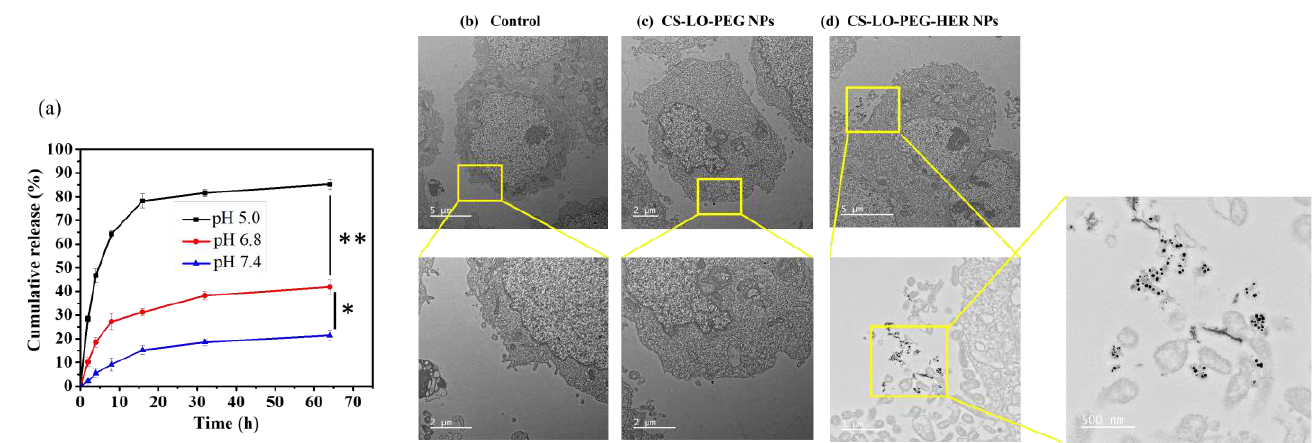
Figure 3. In vitro pH responsive enzyme release from the herceptin (trastuzumab) functionalized L-lysine α -oxidase loaded chitosan-polyethylene glycol (PEG) nanoparticles (CS-LO-PEG-HER NPs; ( a )), cellular internalization without herceptin functionalized (CS-LO-PEG NPs) and herceptin func- tionalized (CS-LO-PEG-HER NPs) L-lysine α -oxidase loaded chitosan-polyethylene glycol (PEG) nanoparticles. ( b – d ) shown the nanoparticles internalization in high magnification. ** p < 0.01; * p < 0.05.